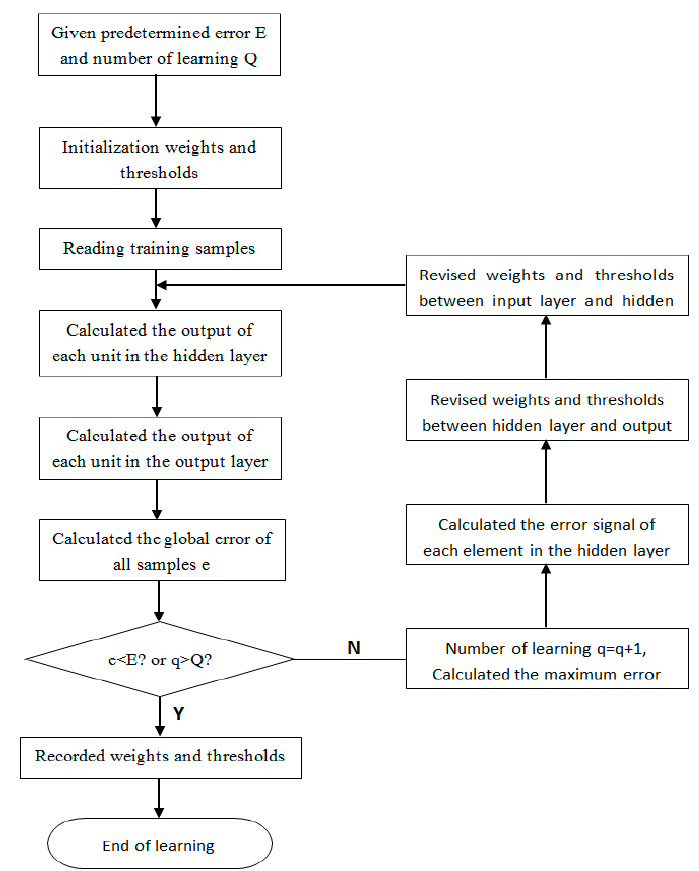
Figure 2. The improved BP algorithm flow.